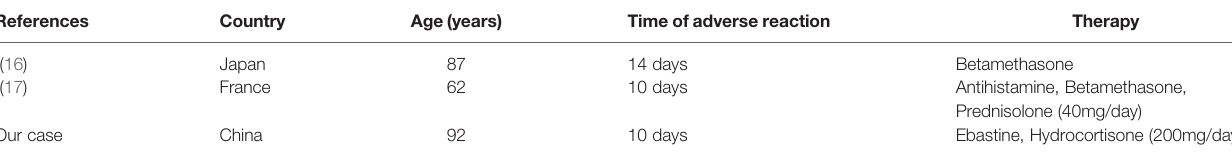
TABLE 1 | Case report of cutaneous adverse events caused by enzalutamide.